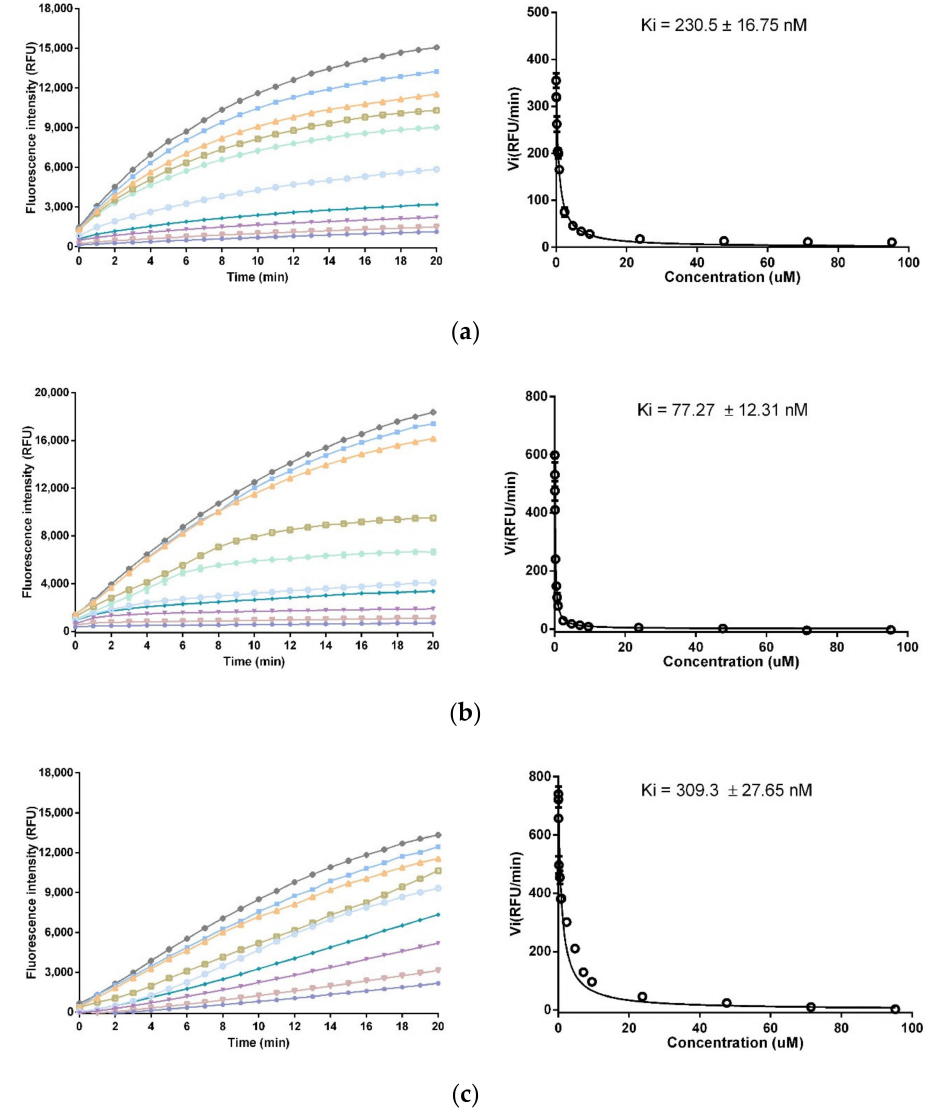
Figure 4. Inhibitory e ff ect of SL-BBI, K-SL and F-SL on trypsin and chymotrypsin. ( a ) Progress curves for trypsin proteolysis under SL-BBI and corresponding Morrison Ki plot performed via final steady-state rates (Vi). ( b ) Progress curves for trypsin proteolysis under K-SL and corresponding Morrison Ki plot. ( c ) Progress curves for chymotrypsin proteolysis under F-SL and corresponding Morrison Ki plot. Data points were fitted to the curve by non-linear regression analysis, using GraphPad Prism. ( 23.81 µ M, (cid:53) 7.143 µ M, (cid:72) 4.762 µ M, (cid:7) 2.381 µ M, # 0.9542 µ M, (cid:7) 0.7143 µ M, (cid:4) 0.4762 µ M, (cid:52) 0.2381 µ M, (cid:4) 0.02381 µ M, (cid:7) 0 µ